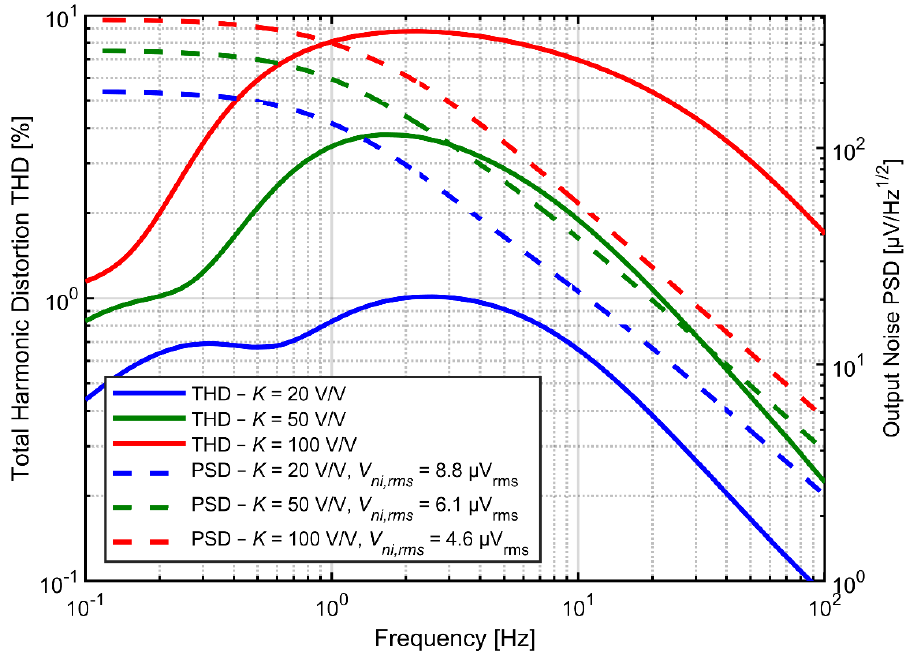
Figure 9. THD as a function of input signal frequency and output noise PSD for various values of K and C f . C in value is fixed at 4 pF and cutoff frequency is fixed at 1 Hz.